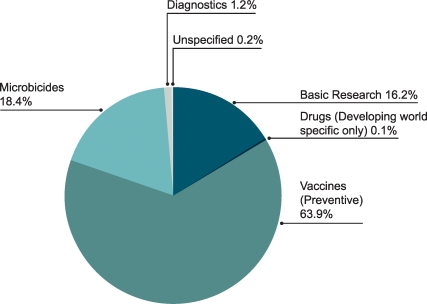
HIV/AIDS R&D Funding in 2007